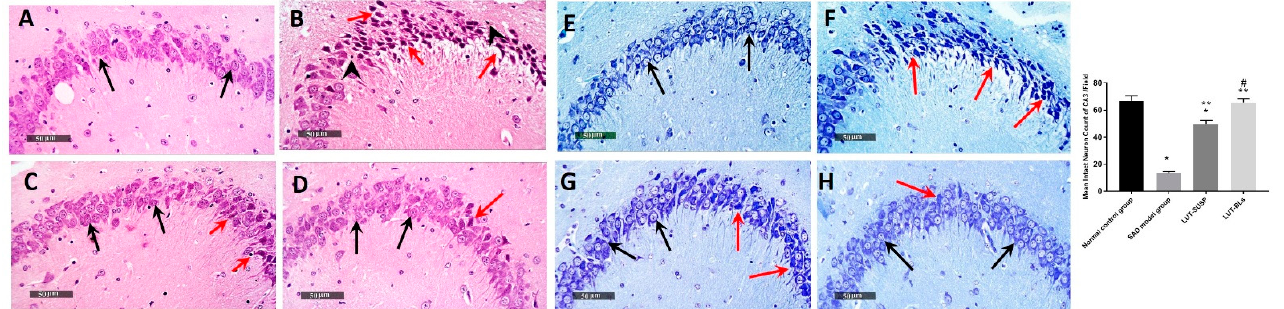
Figure 9. Microscopic examination of the neuroprotective histopathological effect of different groups on CA3 /hippocampal subregions stained with H&E stain ( A ) normal controls, ( B ) model AD samples, ( C ) LUT suspension samples, and ( D ) LUT-BLs samples. Microscopic examination of toluidine-blue-stained pyramidal neurons in CA3/hippocampal subregions in different groups. ( E ) normal controls, ( F ) model AD samples, ( G ) LUT suspension samples, and ( H ) LUT-BLs samples. Black arrows = intact neurons; red arrows = damaged neurons. Data are expressed as means ± SD. * Statistically significant difference from normal control group; ** statistically significant difference from the SAD model group; and # statistically significant difference from LUT suspension group.